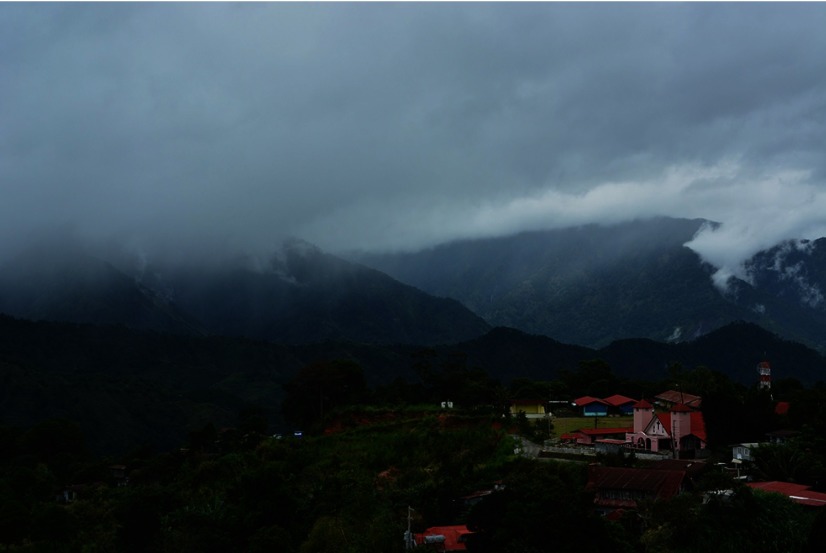
Typical mountainous scenery of Cordillera Administrative Region, Mankayan Municipality, Benguet Province, Philippines. ©2013/Amando Francisco Jr., MCH-CAR Project.